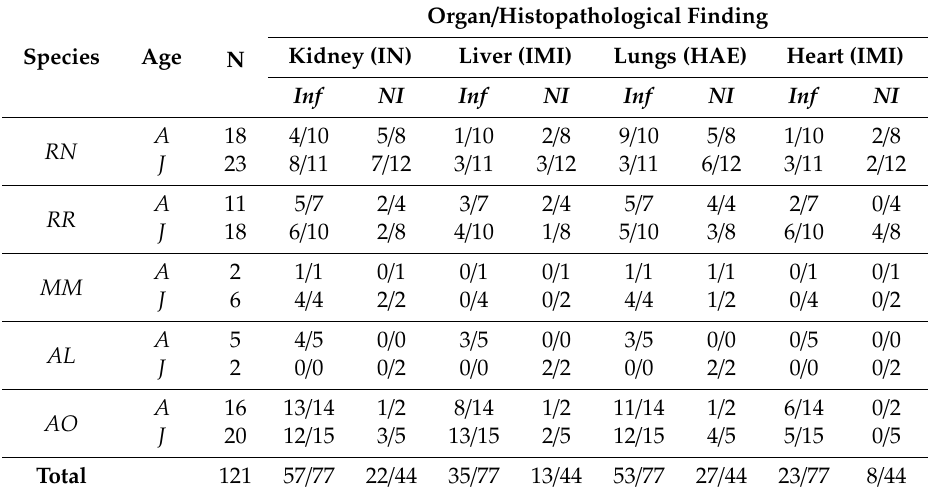
Table 8. Infection status by pathogenic Leptospira and histopathological findings by species and age in rodents trapped in dairy farms in the Los R í os Region, Chile.